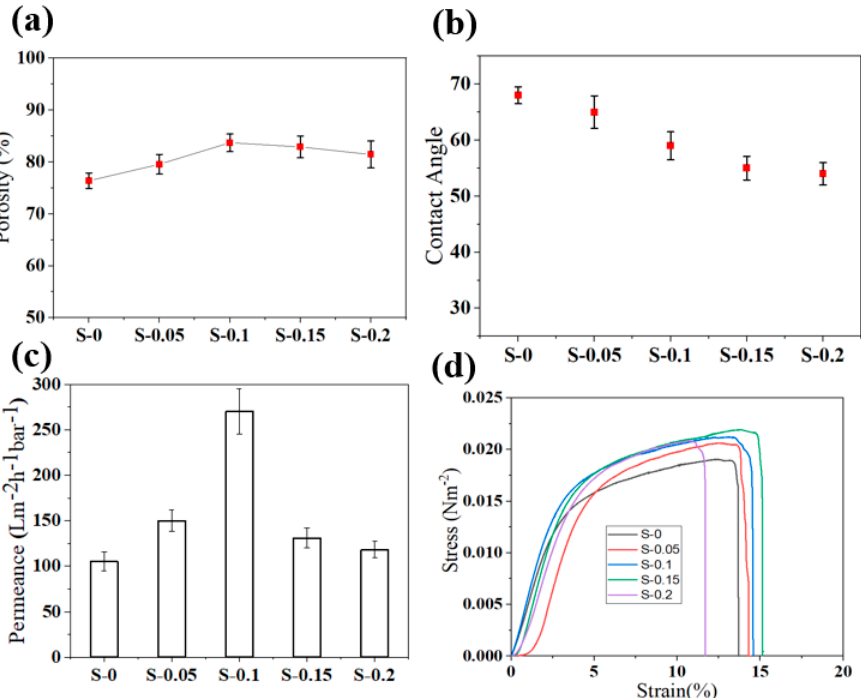
Figure 4. ( a ) Porosity, ( b ) water contact angle, ( c ) permeance, and ( d ) stress–strain curve for all the membrane supports.